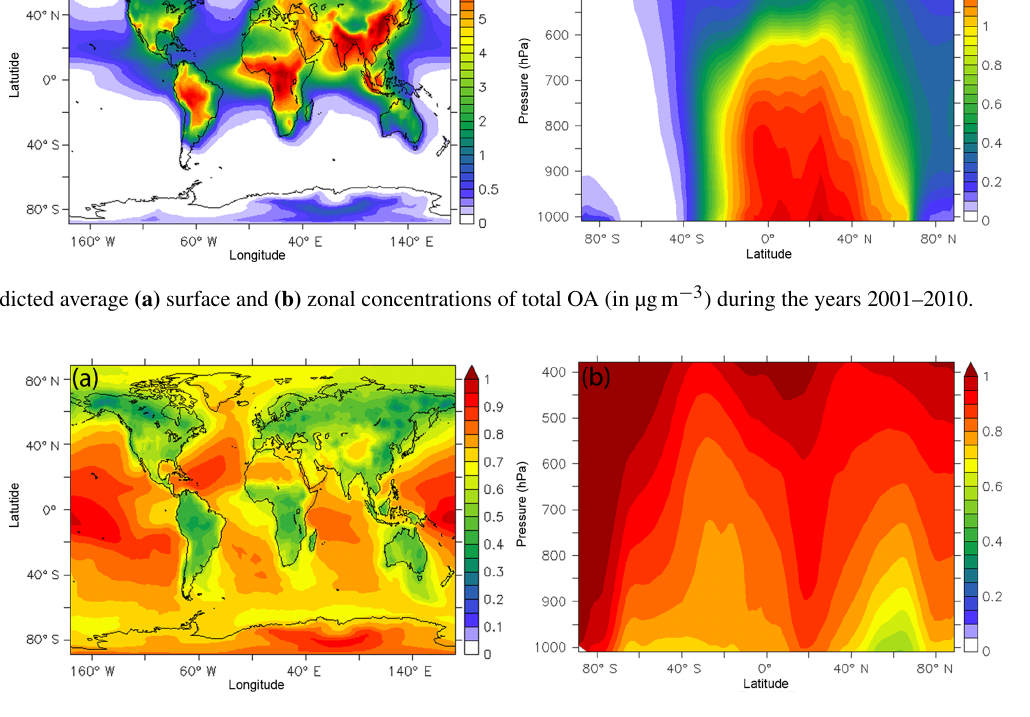
total tropospheric OA burden is 3.3 Tg, which is higher com- pared to the calculated tropospheric burden of ORACLE